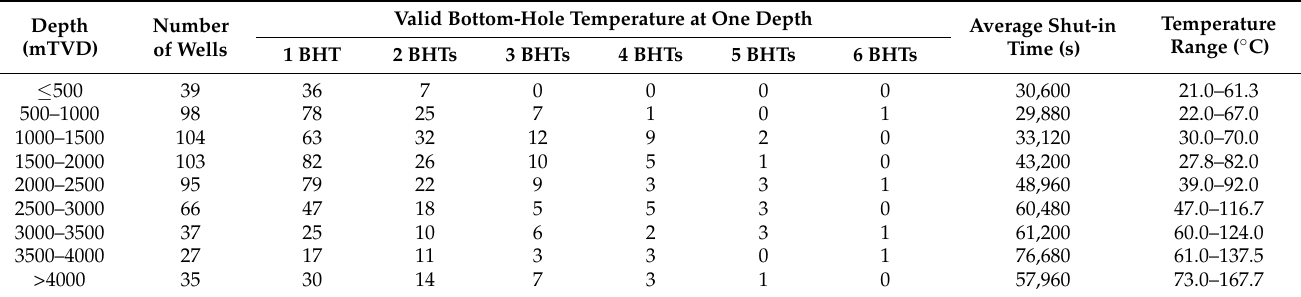
Table 1. The BHT data set structured in steps of 500 m TVD regarding the shut-in time.